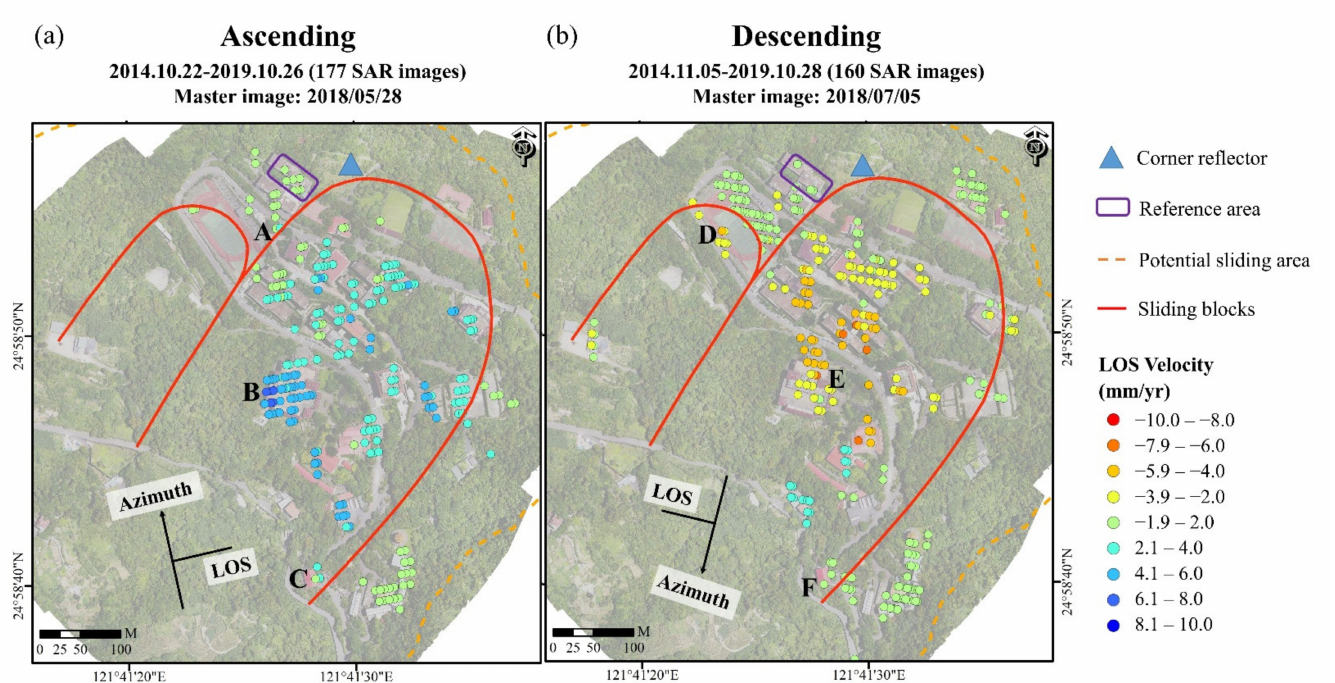
Figure 3. PSInSAR results of ( a ) ascending images and ( b ) descending images. The maximum displacement velocity along the LOS direction was approximately 6.6 mm/yr. A significant slow-moving phenomenon of the Huafan University campus was detected. These figures illustrate the surface displacement along the LOS direction. The red color indicates that the displacement was away from the satellite, while the blue color denotes that the displacement was toward to the satellite. Green circles indicate the relative stable area. Red lines indicate the areas of the two sliding blocks, while the orange